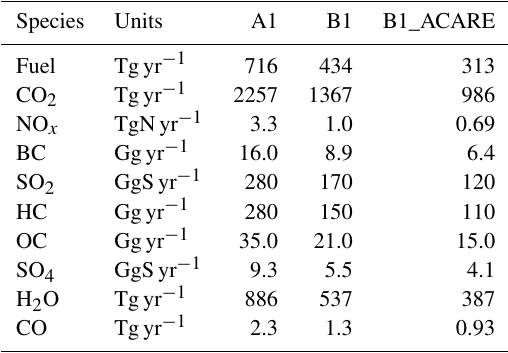
Table 2. Total global aircraft emissions for future 2050 base- line scenario QUANTIFY_A1 and for the two mitigation scenarios QUANTIFY_B1 and